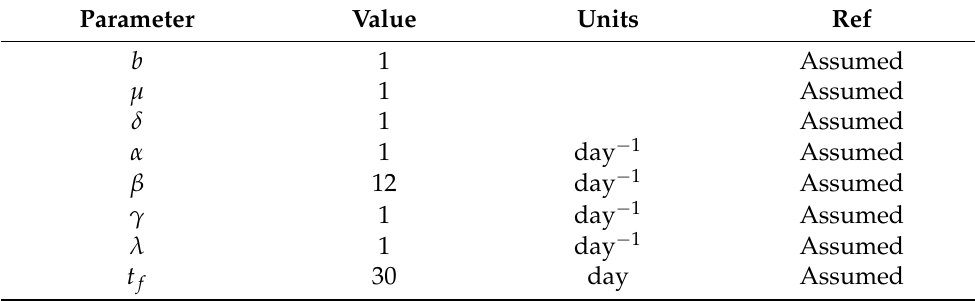
Table 1. Parameter values used in the simulations of Section